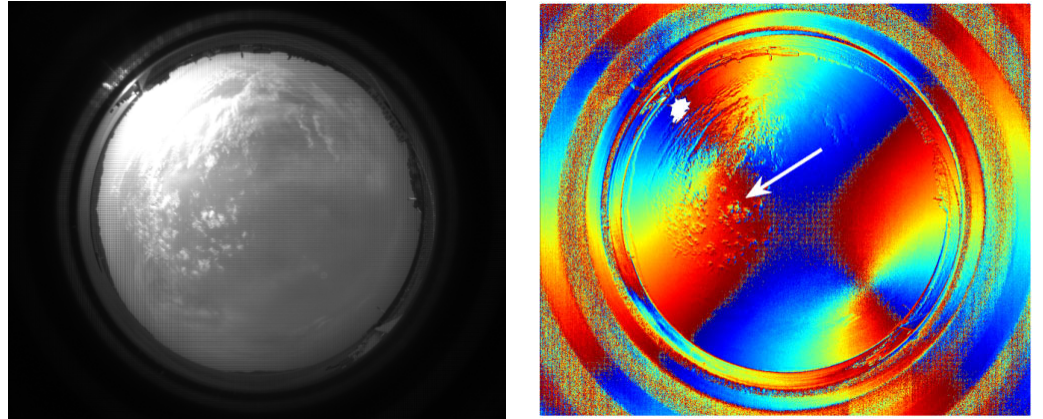
Figure 12. Cloudy sky image acquired by a polarization camera and the corresponding AoP distribution results. The presence of clouds has little effect on the distribution of the original AoP in the sky.